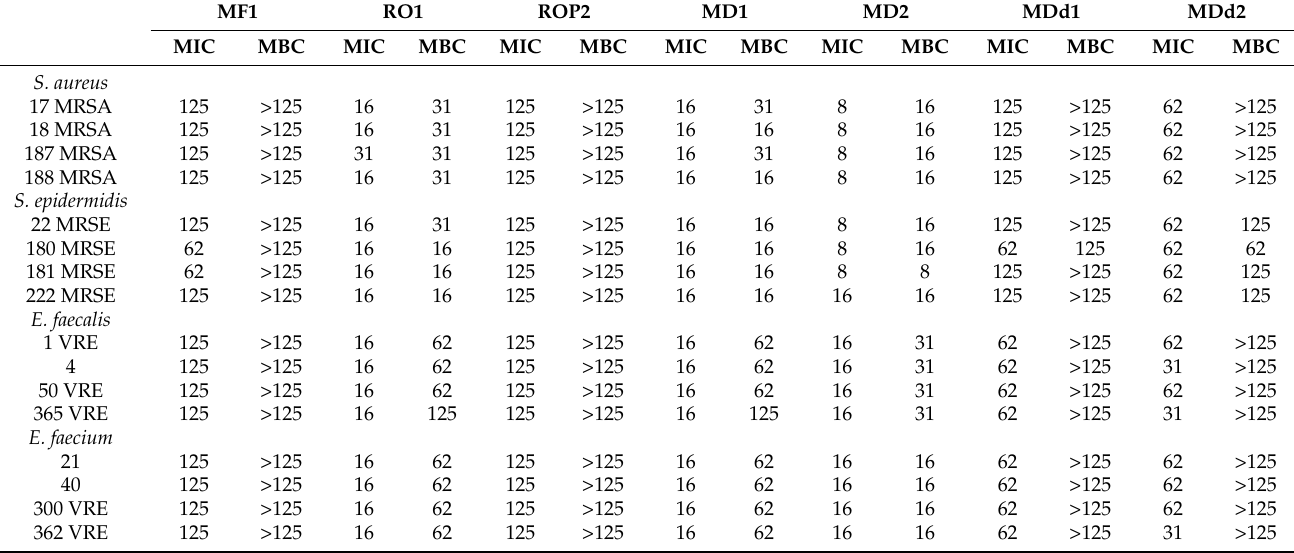
Table 4. MIC and MBC values expressed as mg/mL of the seven OMW samples on the selected Gram- positive strains. Experiments were carried out in triplicate. The degree of concordance in all the exper- iments was 3/3. Variation among triplicate samples was less than 10%. MRSA: methicillin-resistant S. aureus strains; MRSE: methicillin-resistant S. epidermidis strains VRE: vancomycin-resistant